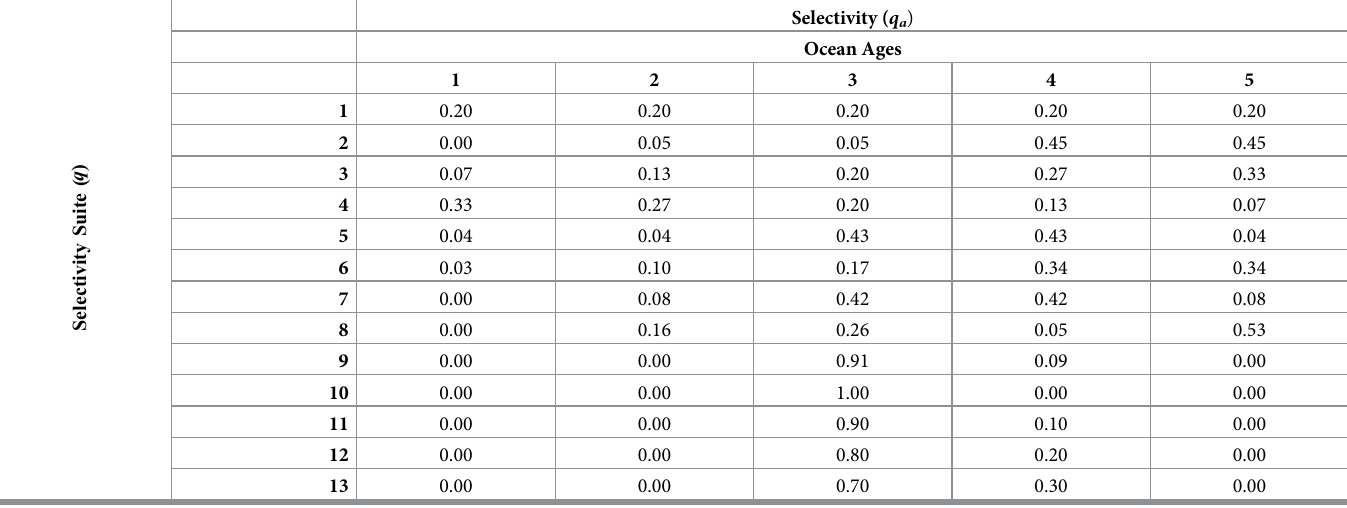
Table 1. Selectivity suites ( q ) determine how additional late-stage mortality is apportioned among ocean age classes ( a ), which are then scaled by different intensi- a ties ( I ) of 0–2.0 to form mortality scenarios ( λ a ).